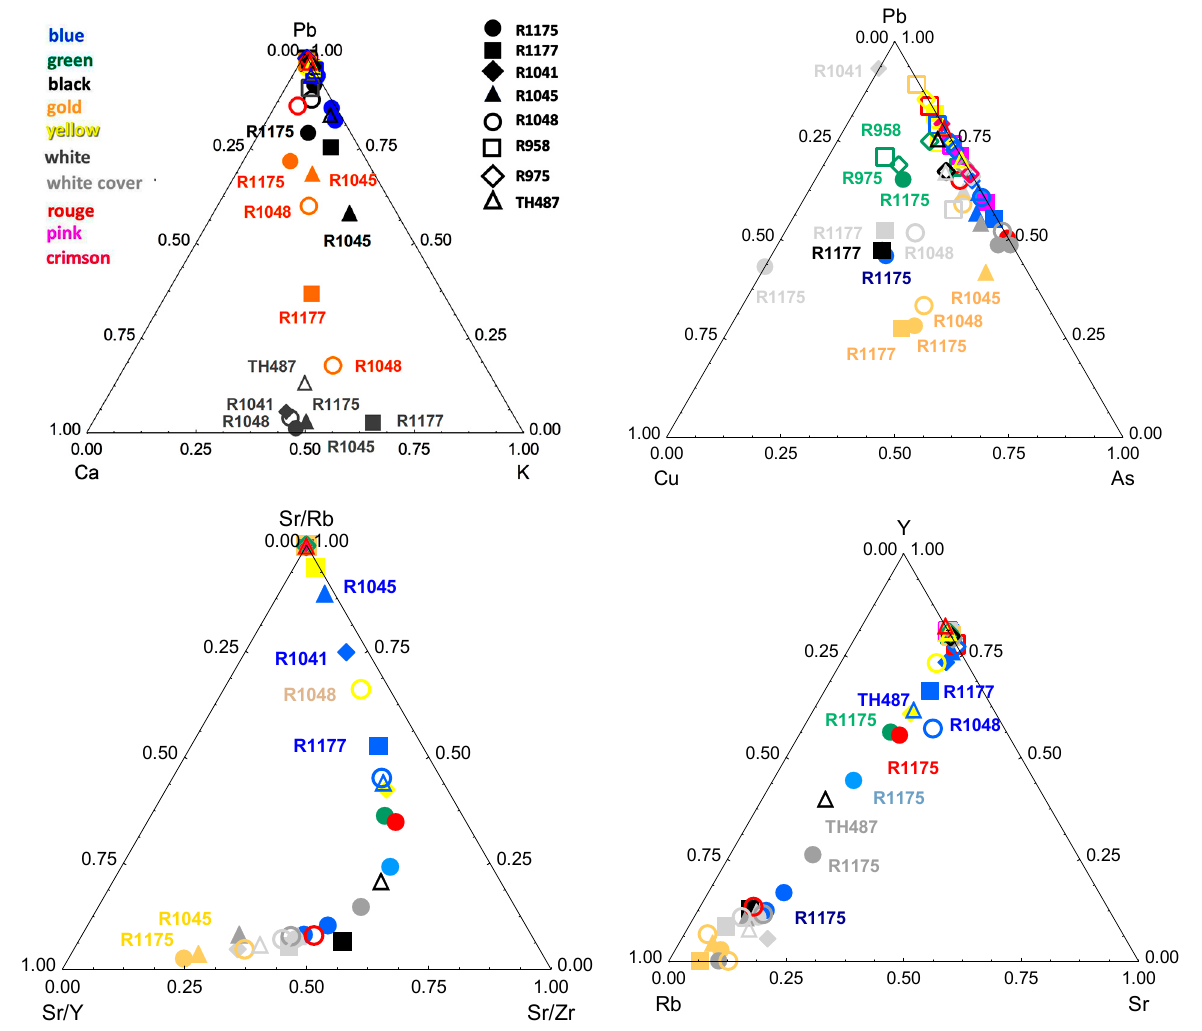
Figure 6. Comparison of signal of flux elements (Pb, Ca, K) of enamel matrices and associated elements (Sr, R, Y, As) (Coll. Louvre). See legend to Figure 5 for explanation of symbols.